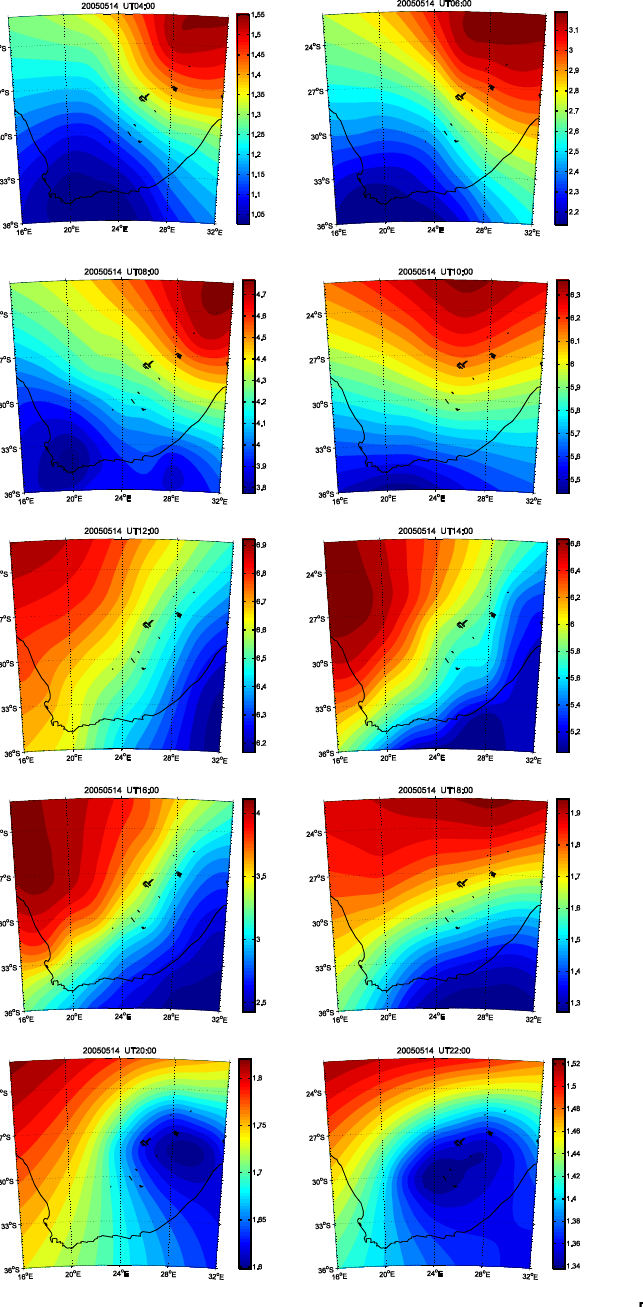
Fig. 4. Map of the electron density changes at an altitude of 350km from 04:00UT on 14 May to 20:00UT on 15 May (unit: 10 11 elm − 3 ) .